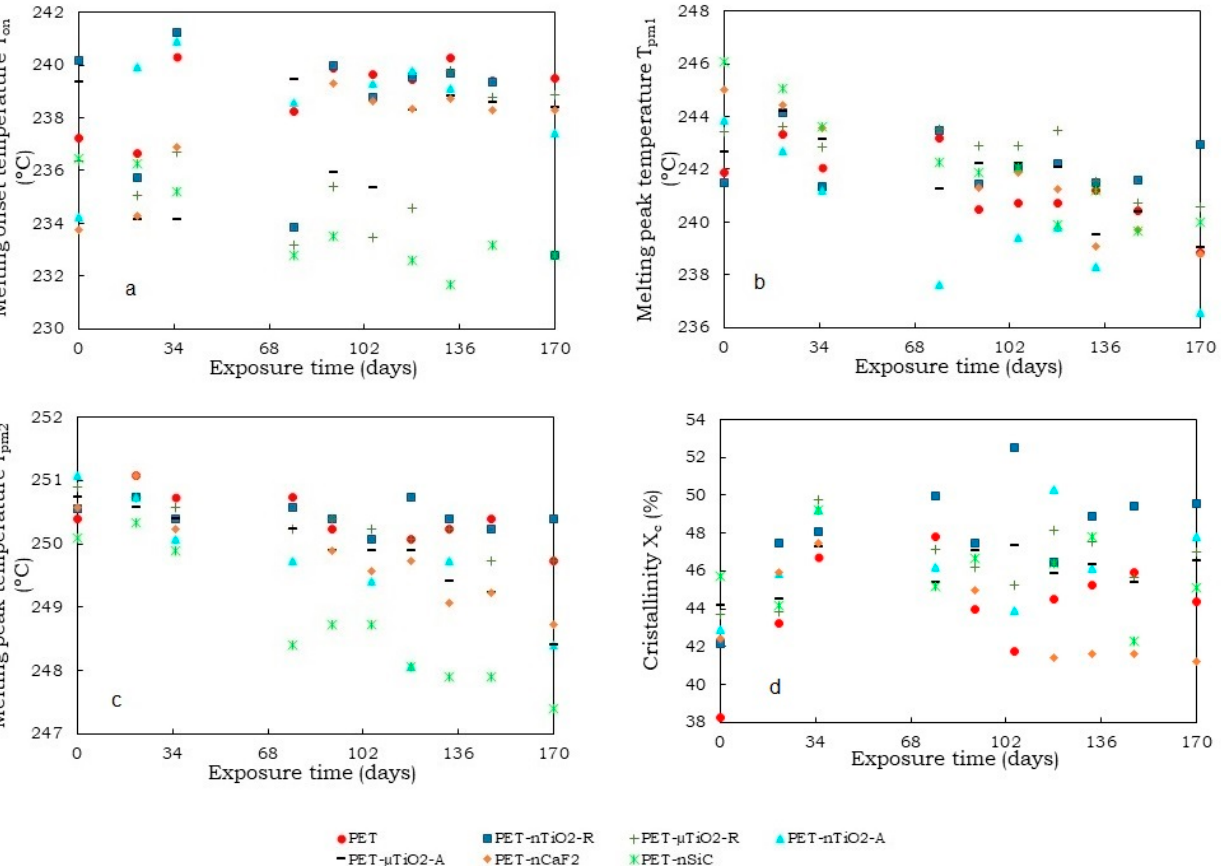
Figure 9. ( a ) Variation in temperatures as a function of the exposure time (2nd heating): ( a ) melting onset temperature ( T on ), ( b ) melting peak temperature ( T pm1 ), (c) melting peak temperature ( T pm2 ), and ( d ) crystallinity (X c ).